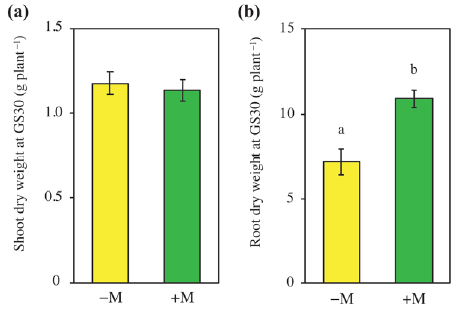
Figure 2. Effect of AMF inoculation on shoot dry weight ( a ) and root dry weight at GS30 ( b ). AMF inoculation and mock control are indicated as +M and − M, respectively.